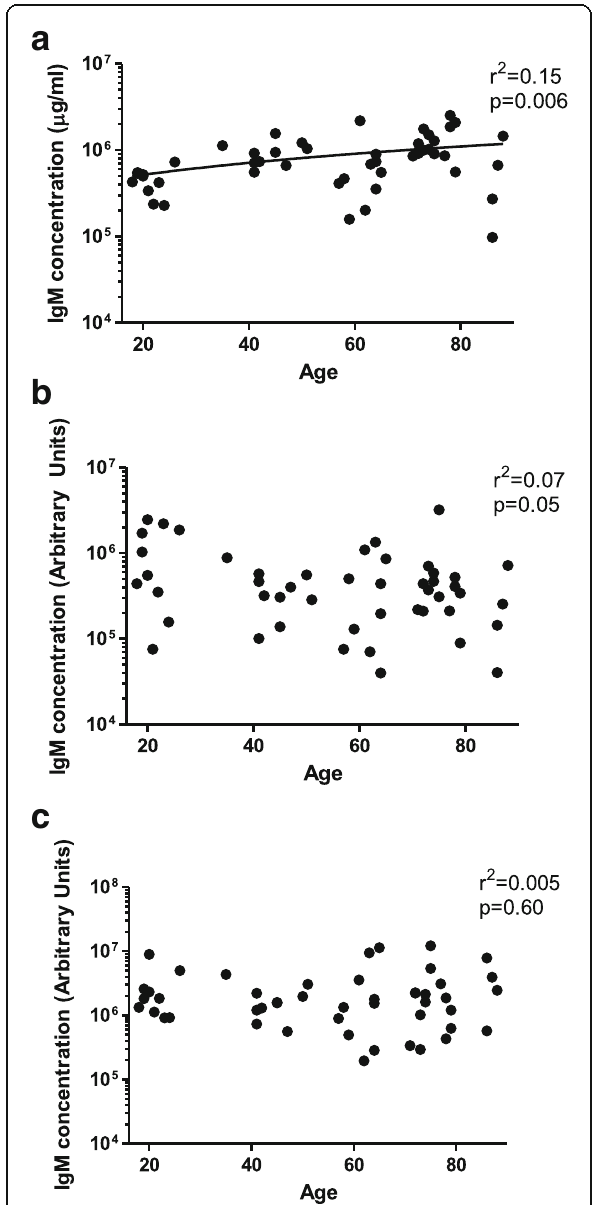
Fig. 2 Levels of IgM in relation to LRTI. The level of total IgM was examined for patients with LRTI, hospital Controls and a young cohort of Healthy volunteers. Levels of ( a ) total IgM, ( b ) IgM to the unencapsulated D39- Δ D pneumococcus and to the ( c ) Pneumococcal Surface Protein A (PspA4) are shown. Mean values ± SD are shown. * p < 0.05 using ANOVA with Bonferroni ’ s